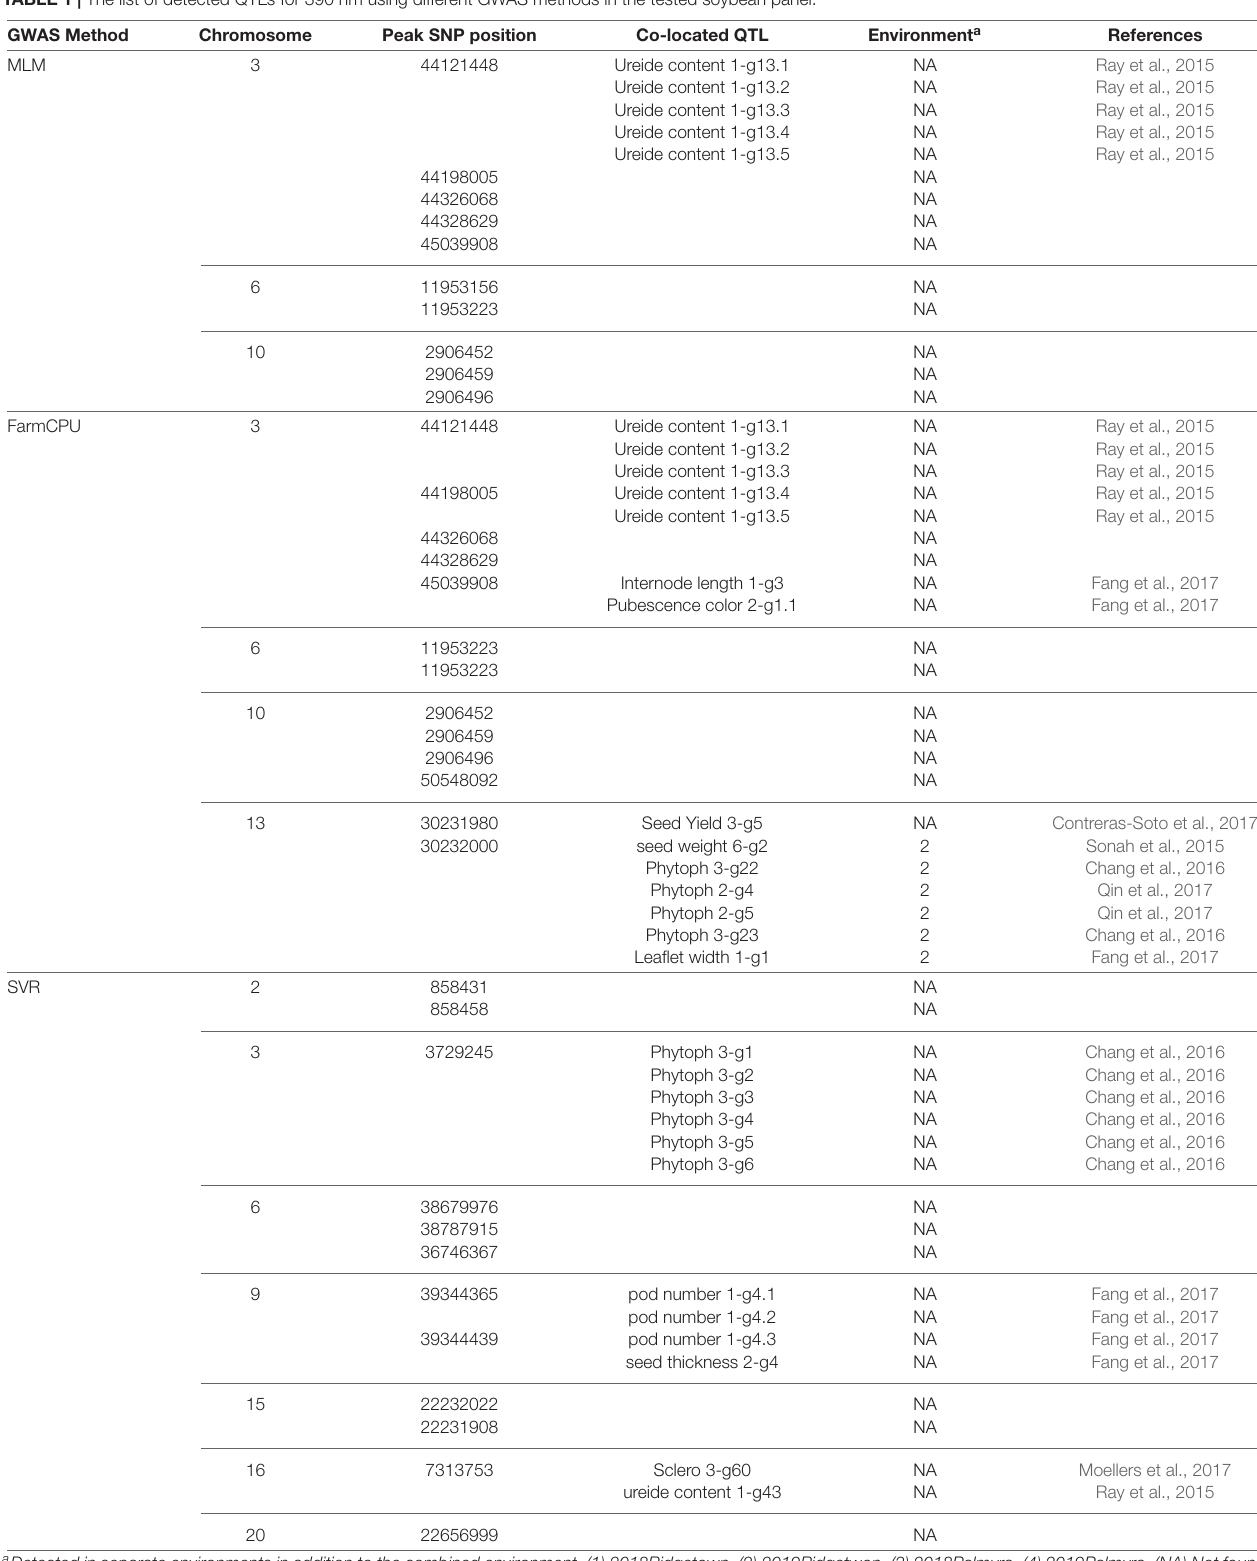
TABLE 1 | The list of detected QTLs for 390 nm using different GWAS methods in the tested soybean panel. GWAS